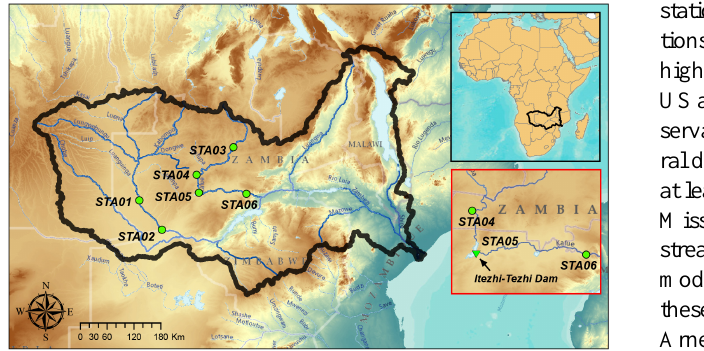
Figure 3. Map of the Zambezi River basin; the solid black line delineates the basin and the green points are the six GRDC sta- tions (STA01-06), with STA06 downstream of the Itezhi-Tezhi dam